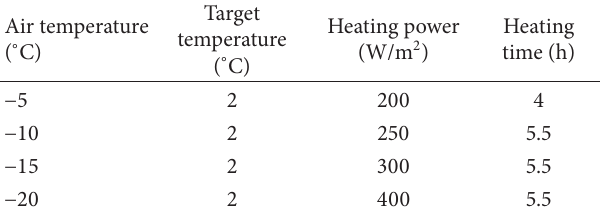
Table 5: Optimal preheating time with thermal insulation